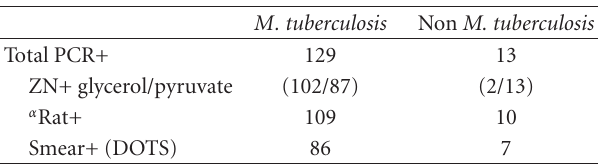
Table 1: Samples classified as M. tuberculosis and non- M. tubercu- losis by Multiplex PCR.